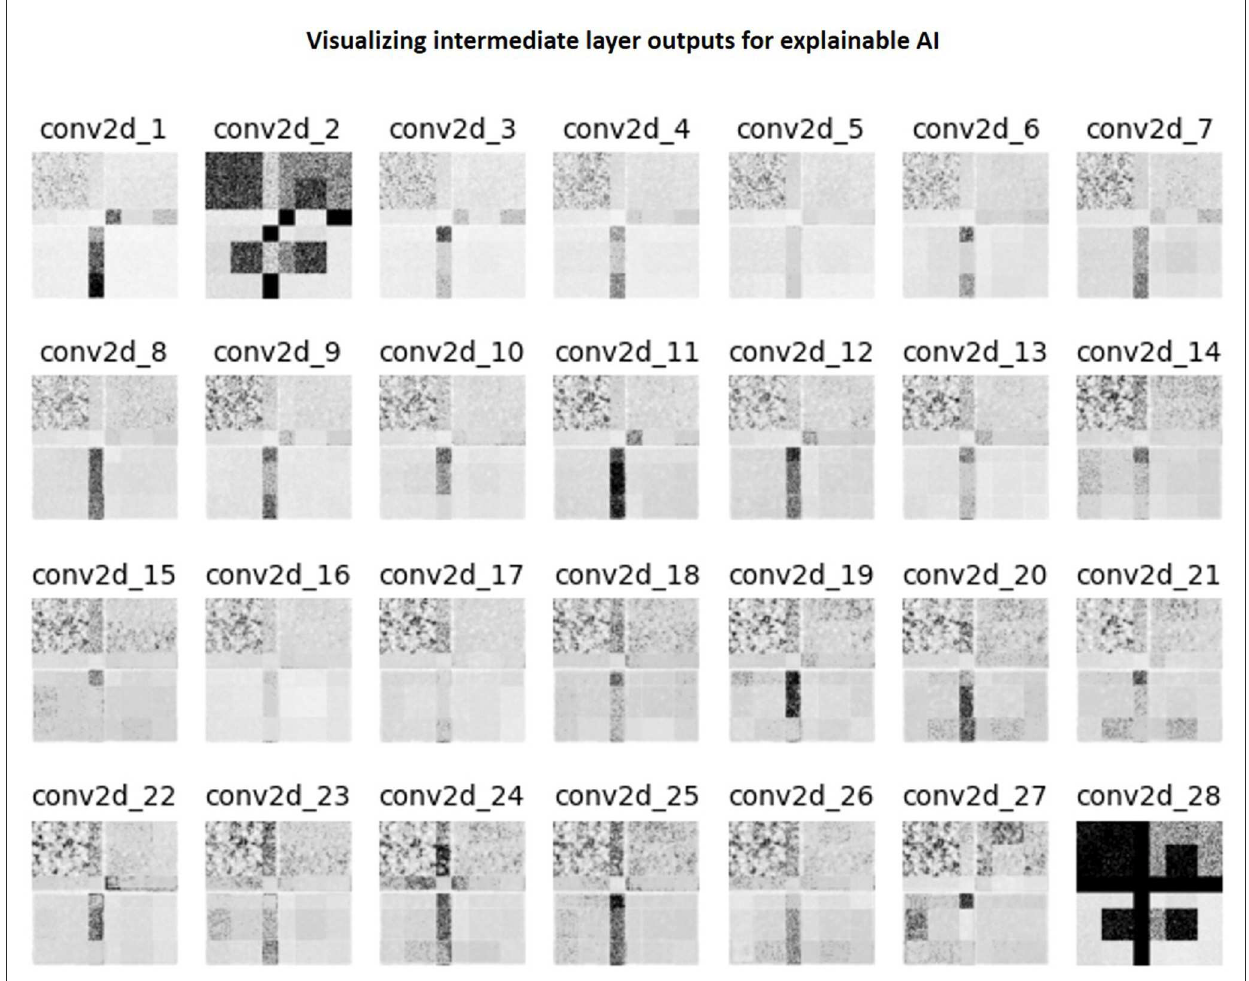
FIGURE11 Collage of intermediate 2D convolutional layer outputs. The filter outputs from each layer were collapsed into a single image via maximum intensity projection. Subsequently, this image was normalized to lie in the range [0, 1.0] and then thresholded to only retain values >